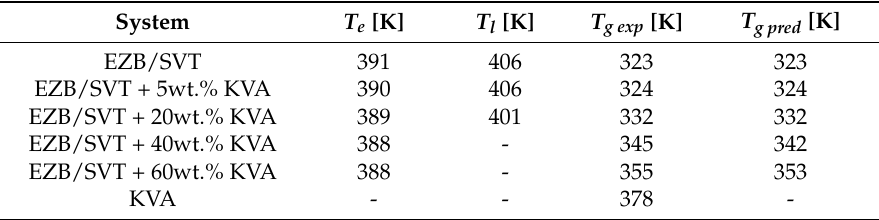
Table 1. Comparison of T e , T l , T g exp , and T g pred values of pure KVA, the binary mixture of EZB/SVT, as well as the ternary system of EZB/SVT/KVA containing 5, 20, 40 and 60 wt. % of